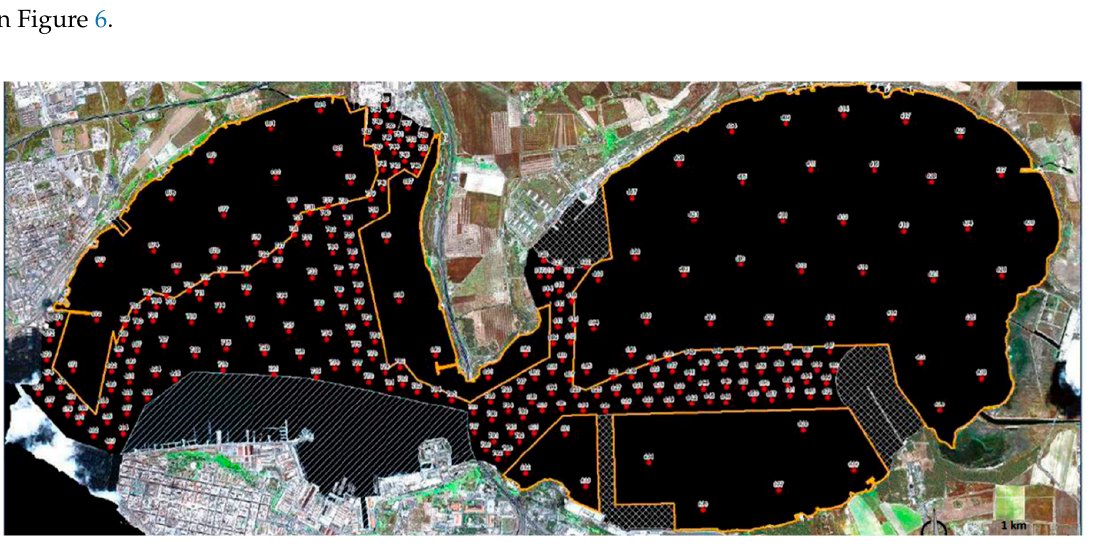
Figure 6. Maps of the sampling points from 2005 to 2010 [42].